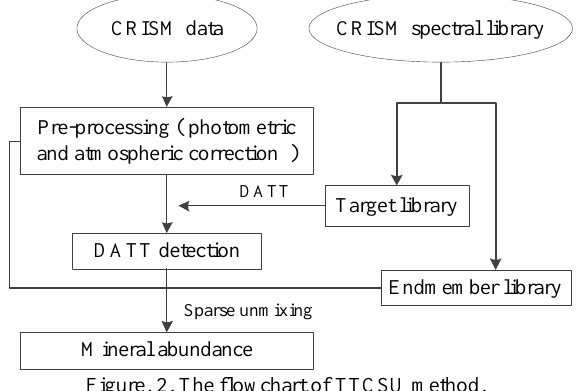
Figure. 2. The flowchart of TTCSU method.